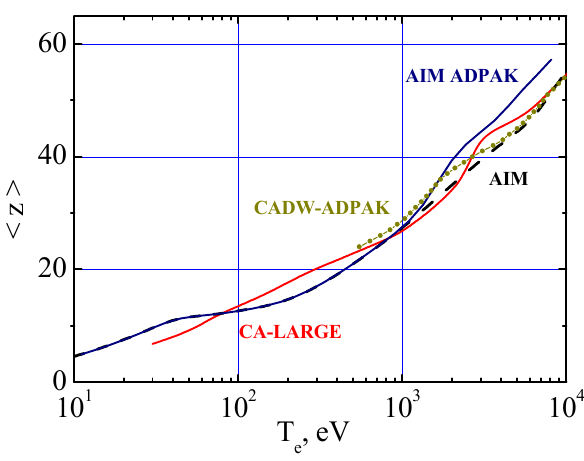
Figure 4. Average charge of tungsten ions versus electron temperature in coronal equilibrium according to data from [1,7] (AIM ADPAK), [3] (CADW-ADPAK), [4] (CA-LARGE) and [20]